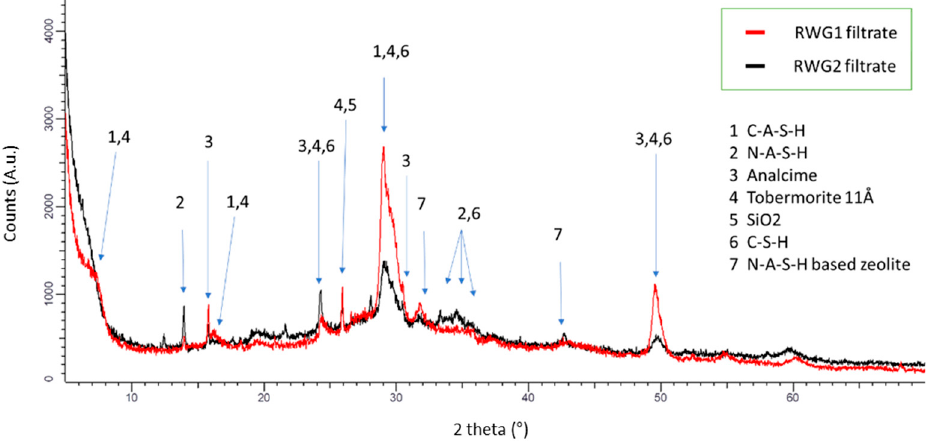
Figure 1. XRD pattern of the RWG1 and RWG2 filtrates.